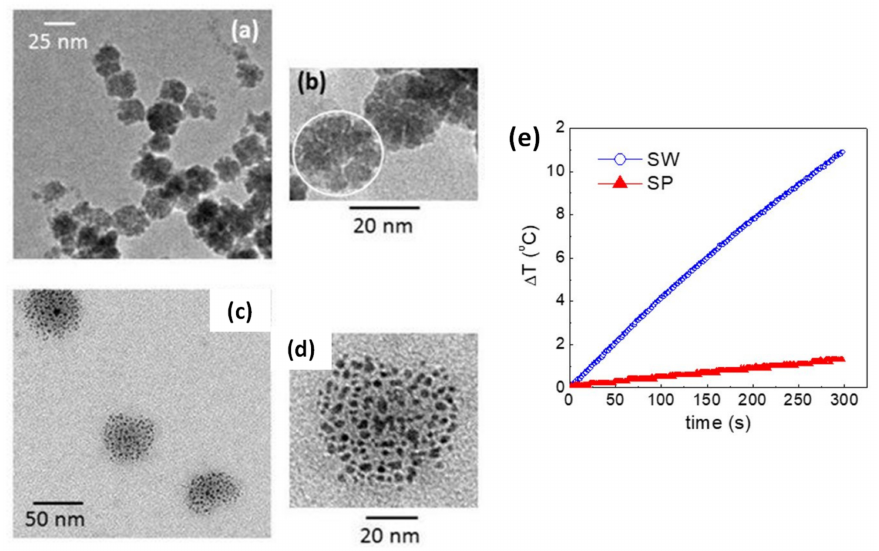
Figure 7. ( a , b ) TEM images of iron oxide MC_NPs dispersed in water (sample SW); in ( b ) the white circle highlights one MC_NP consisting of primary NPs capped with 2-pyrrolidone. ( c , d ) TEM images of the MC_NPs dispersed in polyethylene glycol 400 (PEG) (sample SP), showing how the primary NPs tended to separate from each other. ( e ) Heating curves for samples SW and SP in an AMF of 13.5 kA7m and 177 kHz. Adapted from Ref. [151] under CC BY 4.0 License.